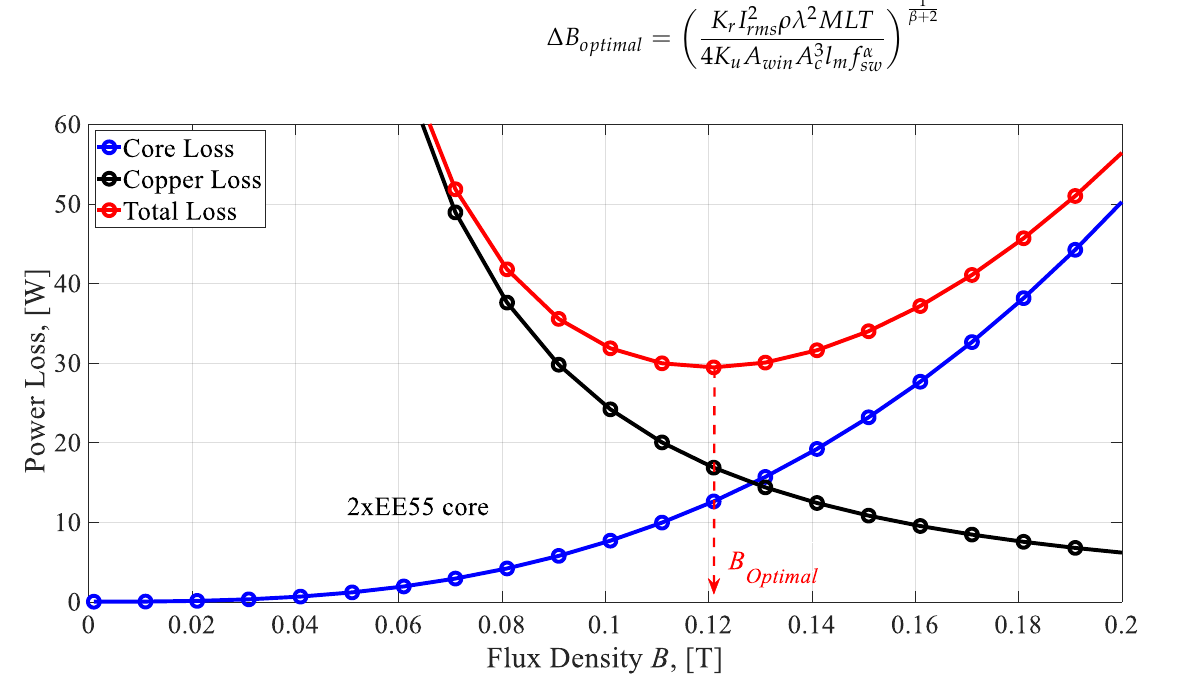
Figure 7. The optimal flux density versus the total power loss of the high-frequency